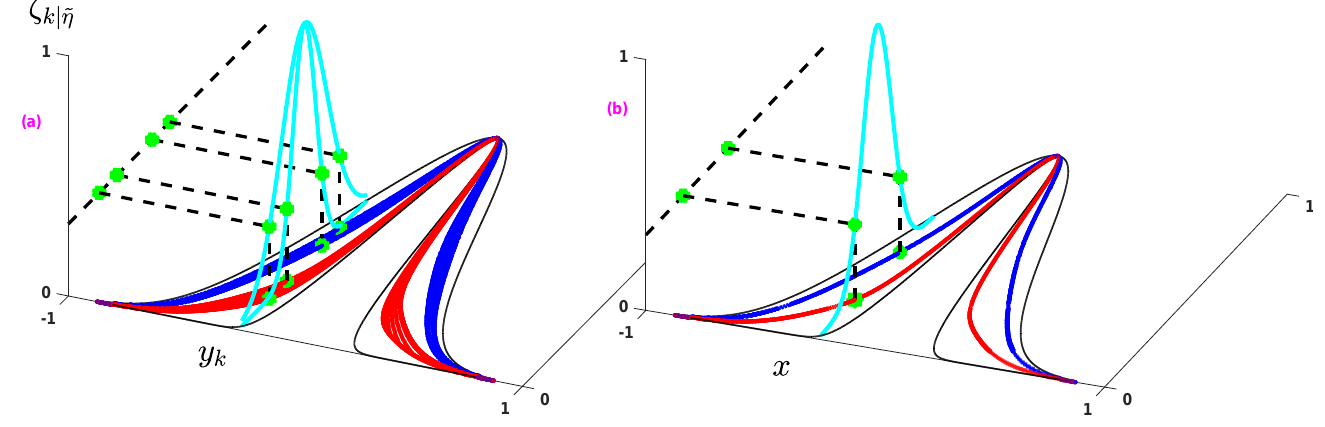
Figure 2. Comparison of fuzzy sets: ( a ) type-3 fuzzy set, ( b ): type-2 fuzzy set.